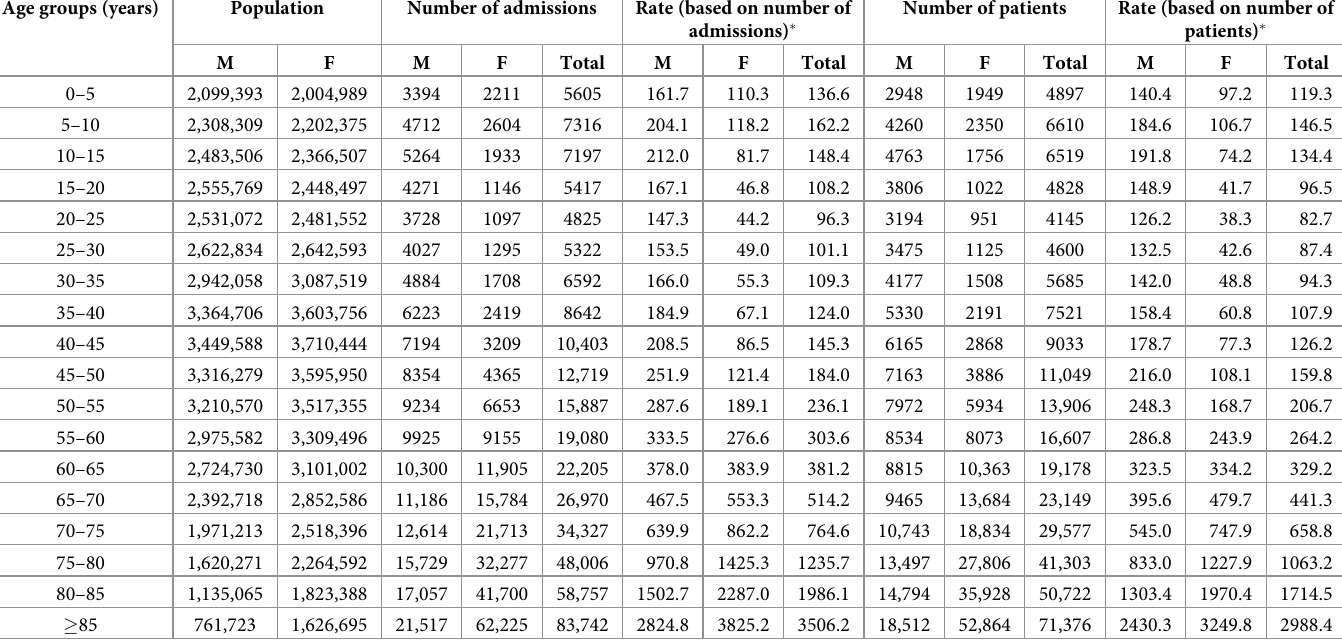
Table 2. Distribution of rates of falls (per 100,000 population at risk) based on patients and admissions related to falls, between 2010 and 2018, in the Portuguese population. Age groups (years)